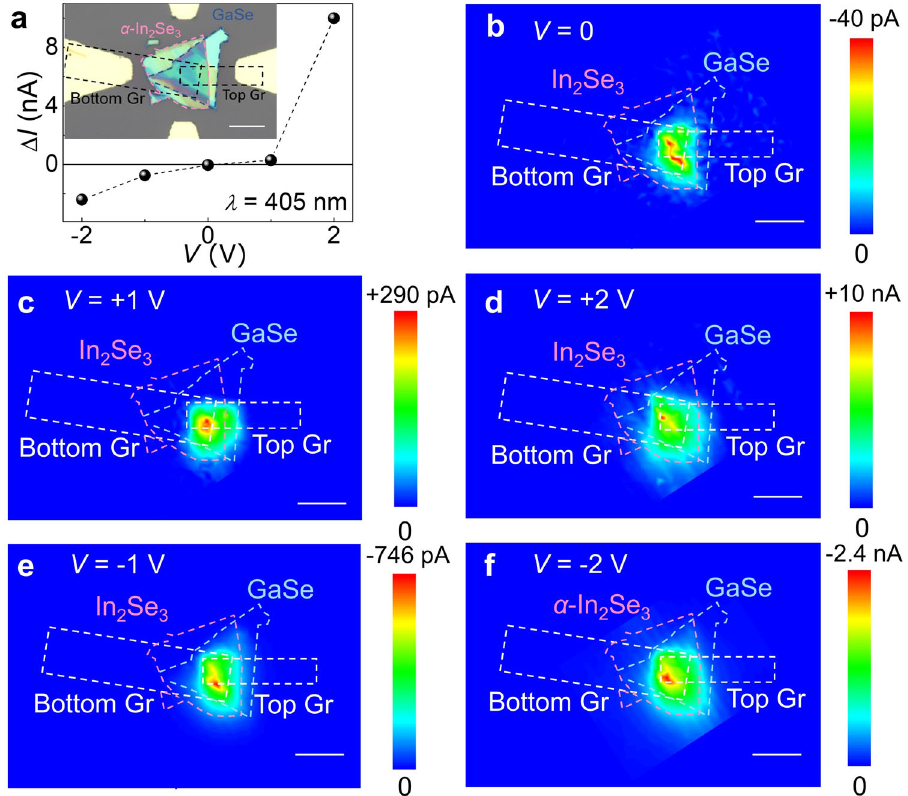
Fig. 4 Photocurrent maps. a Room temperature ( T = 300 K) photocurrent ( Δ I ) versus V under a focused laser beam ( λ = 405 nm and P = 0.75 μ W) for a bulk (thickness of In 2 Se 3 /GaSe ~80/80 nm) junction. The corresponding I – V curves under unfocused laser light are in Fig. 2. The data correspond to the largest value of Δ I at each V . Inset: optical image of the device. Scale bar: 10 μ m. b – f Photocurrent maps under bias V = 0, + 1, + 2, − 1, − 2 V. The laser beam ( λ = 405 nm and P = 0.75 μ W) is focussed by the microscope objective to a spot size of around 1 μ m. Scale bar: 10 μ